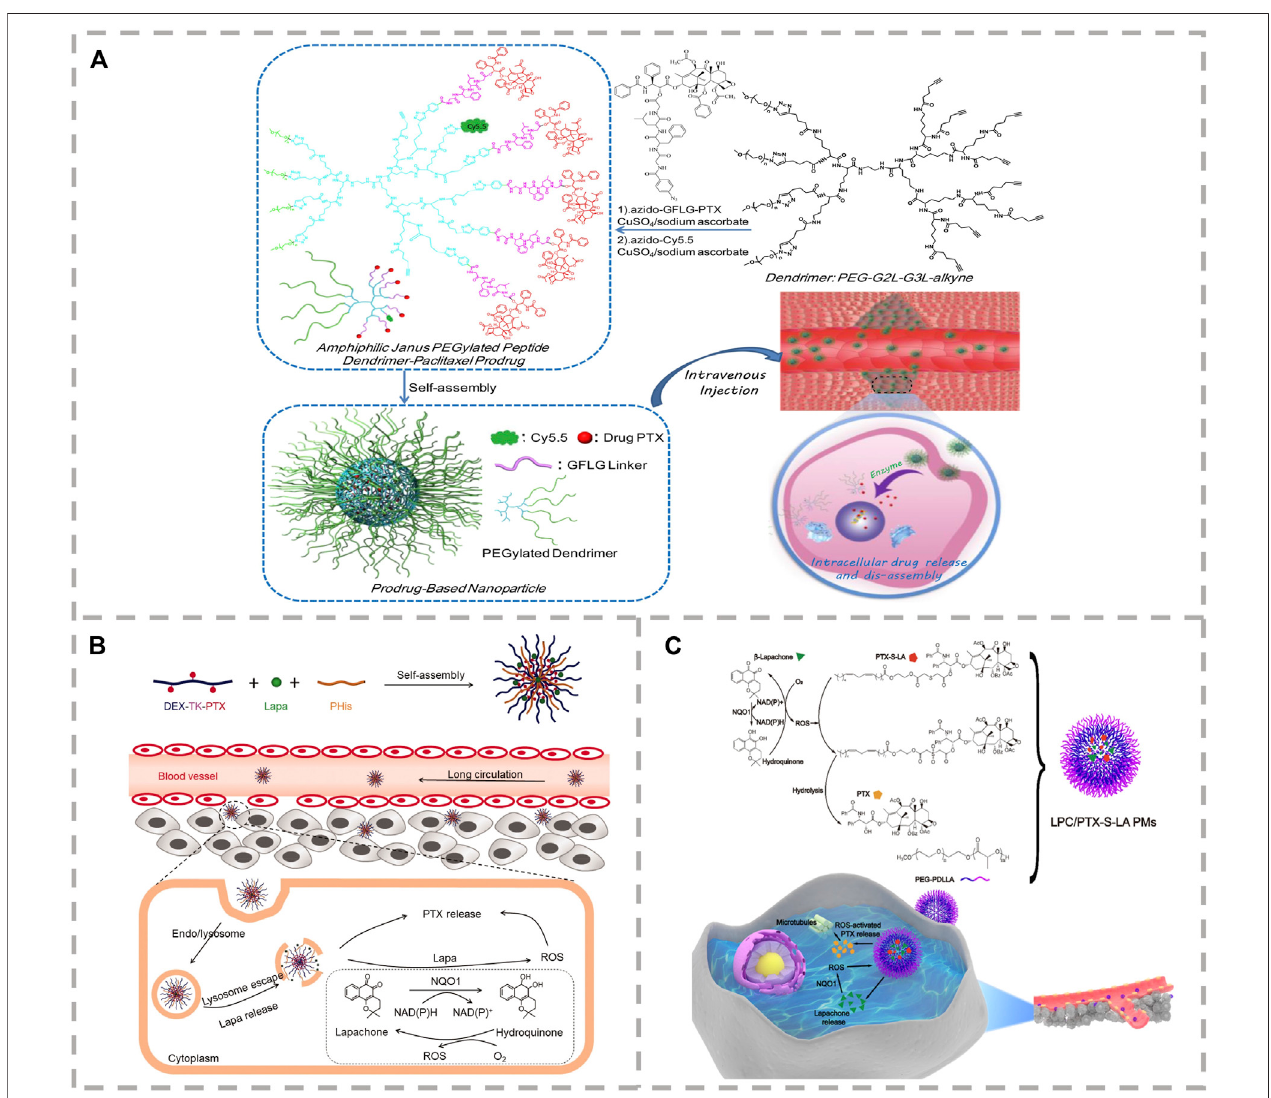
FIGURE 3 | (A) Structure and synthesis of enzyme-sensitive amphiphilic Janus PEGylated dendrimer-GFLG-PTX prodrug and its released PTX from prodrug through intracellular enzymolysis after endocytosis (Li et al., 2017). (B) A DEX-TK-PTX – based self-accelerating drug release nanodrug delivery system (PLP-NPs) with pH/ROS cascade response was constructed for the treatment of multidrug resistant colon cancer (Chang et al., 2020). (C) Self-strengthened bioactivating prodrug- based NPs are fabricated via co-encapsulation of ROS-sensitive thioether-linked linoleic acidpaclitaxel conjugates (PTX-S-LA) and β -lapachone (LPC) into polymeric micelles (PMs) (Wang K. et al.,